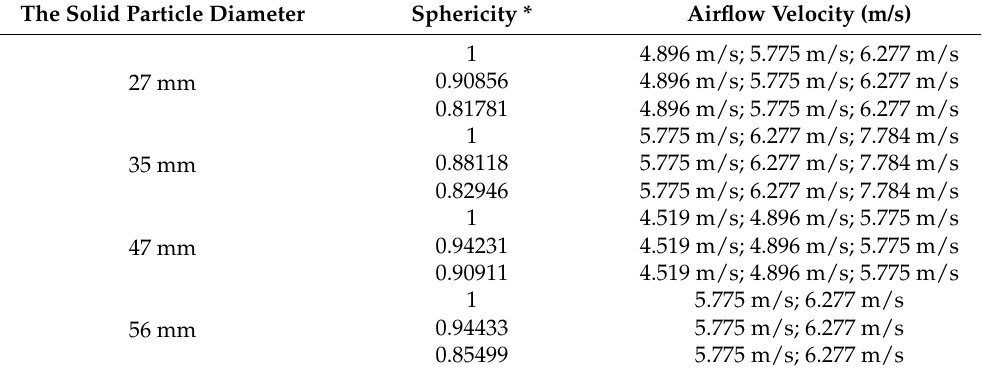
Table 1. Presentation of input parameters [Reprinted/adapted with permission from Ref. [19]. 2020, Ristea M.]. The Solid Particle